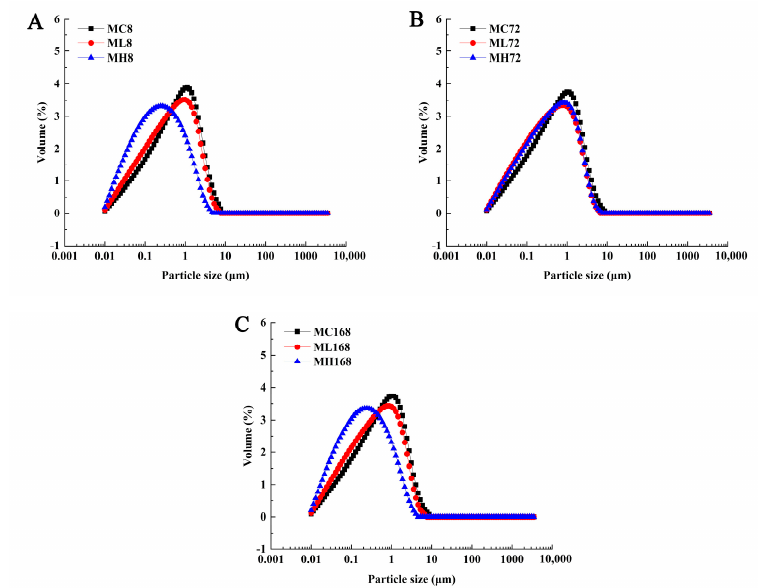
Figure 7. Analysis of particle size of milk samples stored for 8 h under three homogenization pressures ( A ). Analysis of particle size of milk samples stored for 72 h under three homogenization pressures ( B ). Analysis of particle size of milk samples stored for 168 h under three homogenization pressures ( C ).